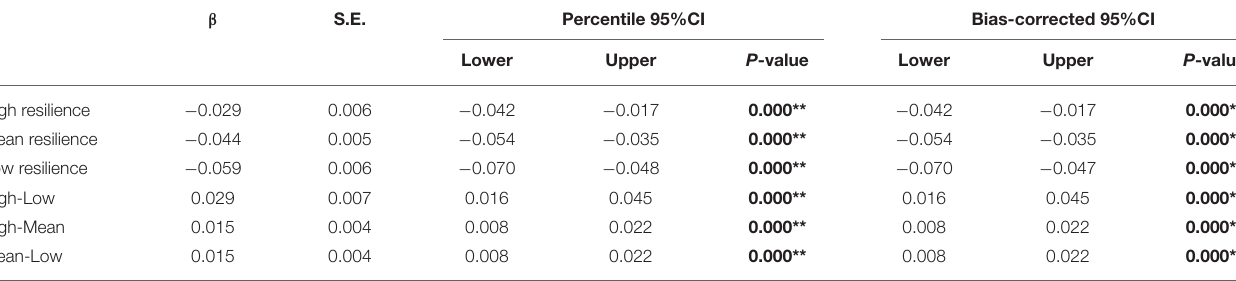
TABLE 6 | Bootstrap results of the moderating effects of resilience on the direct association between workplace bullying and subjective wellbeing.